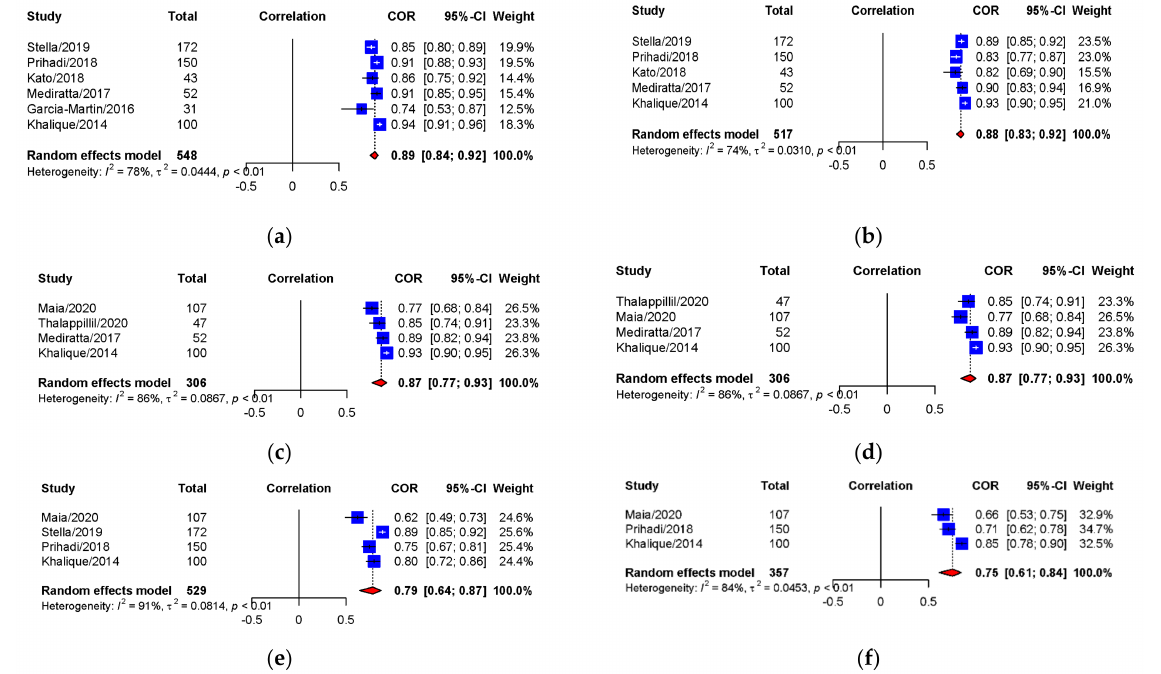
Figure 3. Forest plots of correlation between 3D-TEE and MDCT for annular sizing parameters. ( a ) Aortic annular area; ( b ) Aortic annular perimeter; ( c ) Annular area-derived diameter; ( d ) Annular perimeter-derived diameter; ( e ) Annular maximum diameter; ( f ) Annular minimum diameter. 3D-TEE = Three-dimensional transesophageal echocardiography, MDCT = Multidetector computed tomography, CI = Confidence interval, COR = Correlation